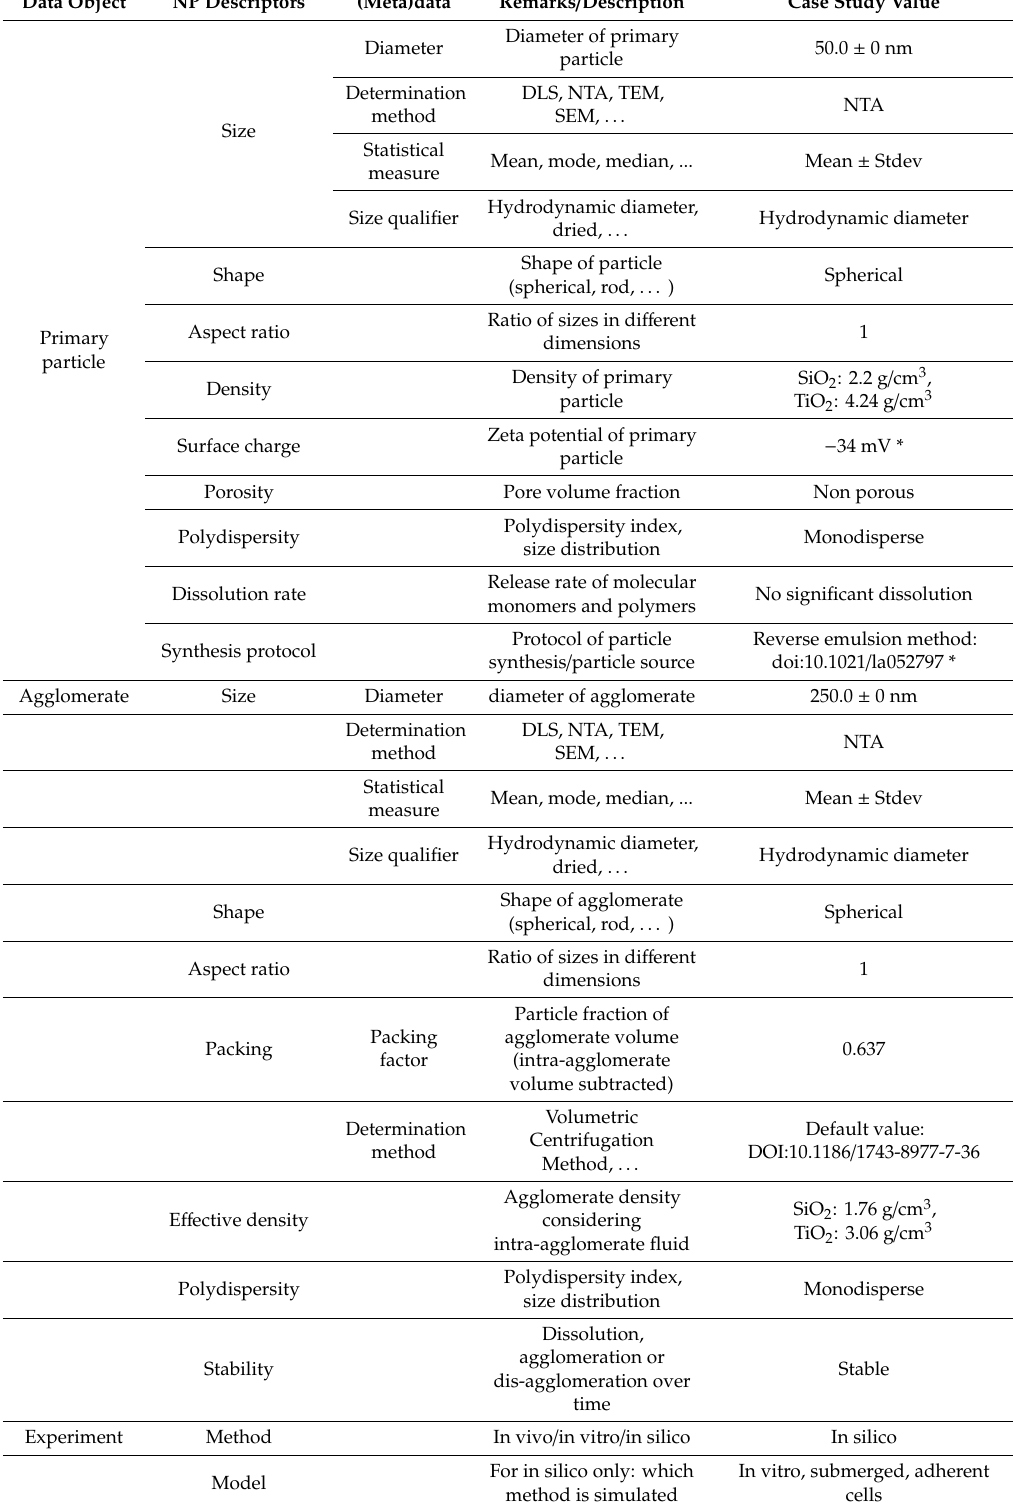
Table 4. NP agglomeration-related metadata relevant for DD assessment as a means to facilitate correct interpretation of in vitro bioassays and support data